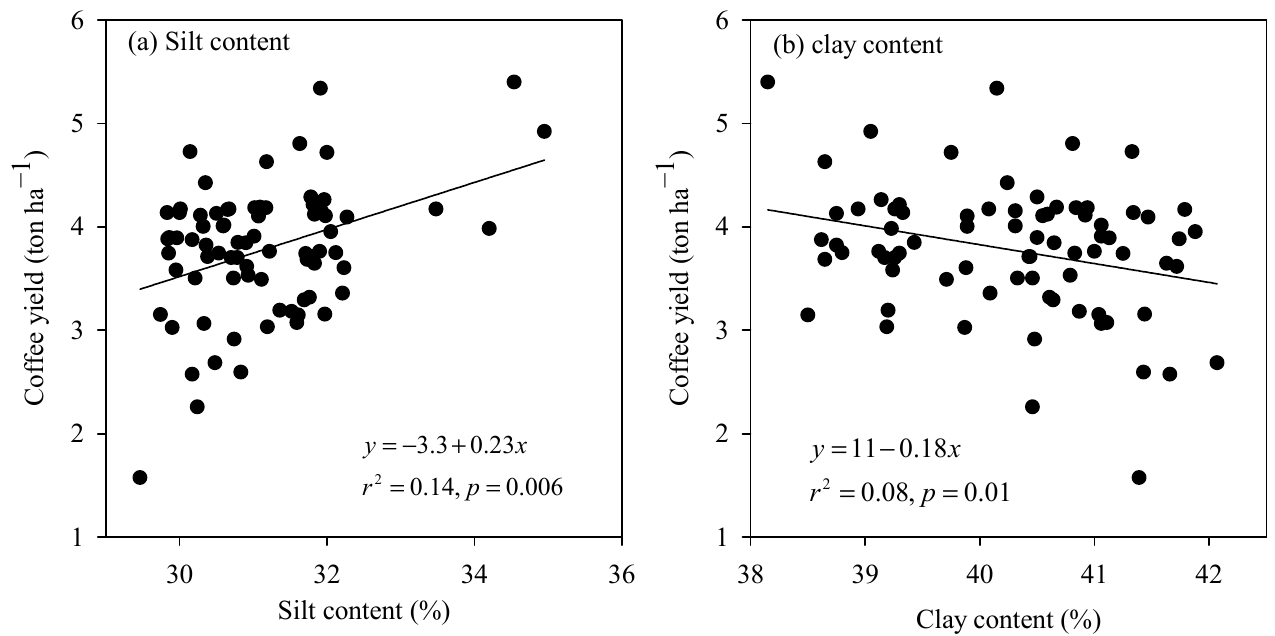
Figure 4. The relationship between coffee yield with ( a ) silt and ( b ) clay content of the clay soil. Table 4. The contribution of examined factors to the total variance of coffee yield in two soils. *